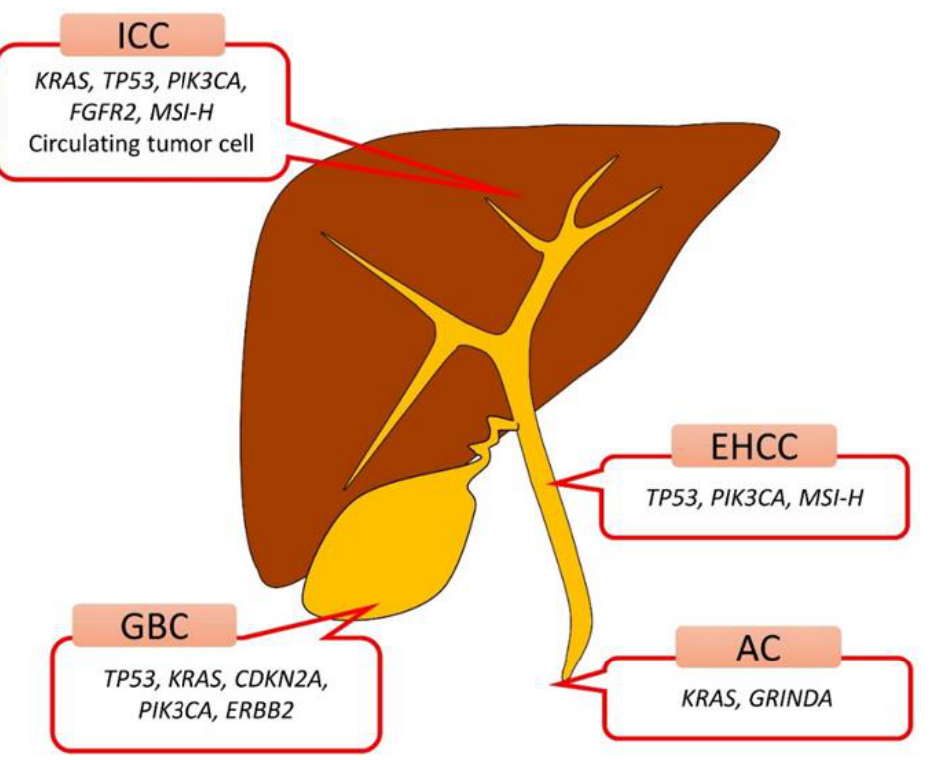
Figure 1. Major genetic mutation spectrum according to the biliary tract site revealed by EUS- FNA/FNB specimens. AC, ampullary cancer; EHCC, extrahepatic cholangiocarcinoma; GBC, gallbladder cancer; ICC, intrahepatic cholangiocarcinoma; MSI-H, microsatellite instability-high.